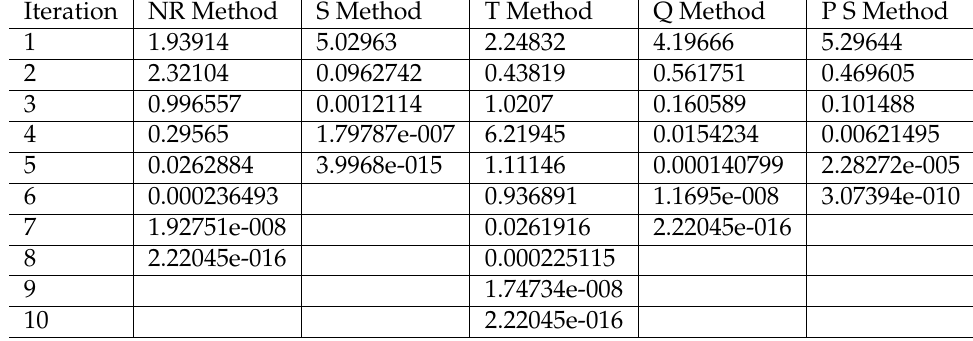
Table 8. Error analysis of NR Method, S Method, T Method, Q Method and P S Method for the Equation